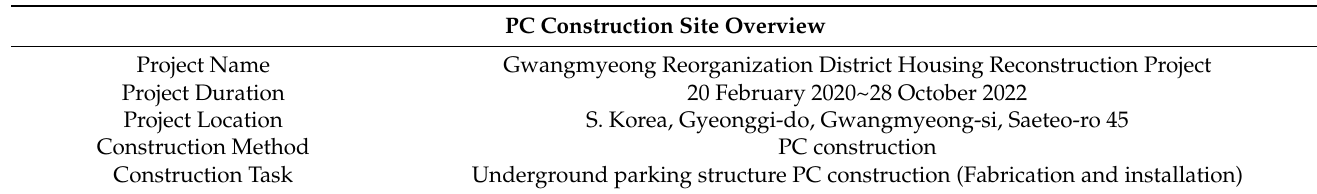
Table 3. Overview of the PC construction site for the system field application.